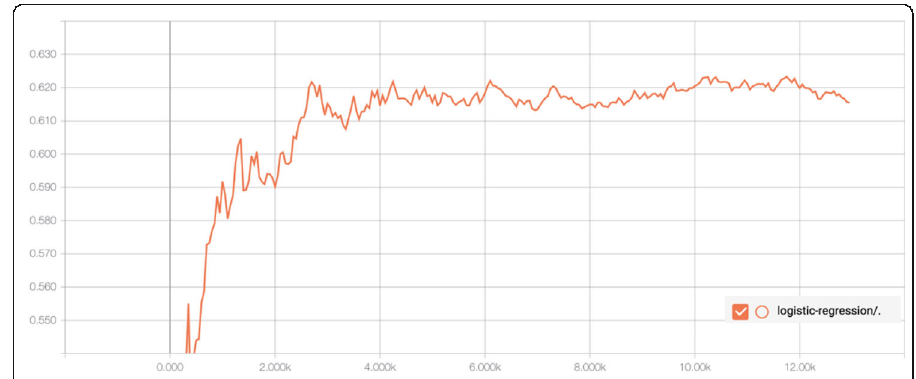
Fig. 21 The result of logistic regression